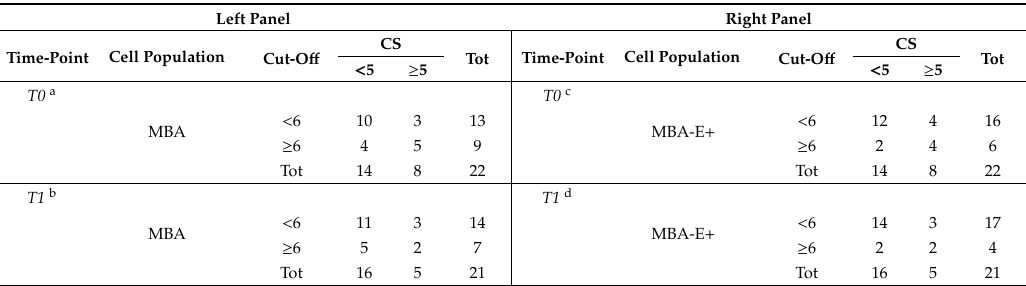
Table 3. Concordance of CTC status between the metabolism-based assay (MBA) and CellSearch